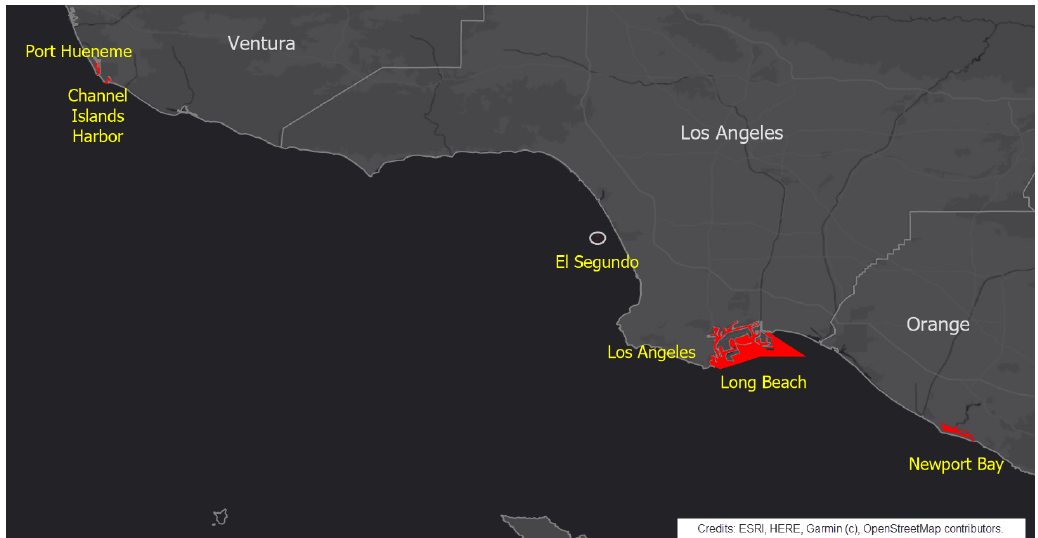
Figure 7. The six ports in the Hestia-LA domain to which Vulcan FFCO 2 port emissions are allocated. © OpenStreetMap contributors 2019. Distributed under a Creative Commons BY-SA License.